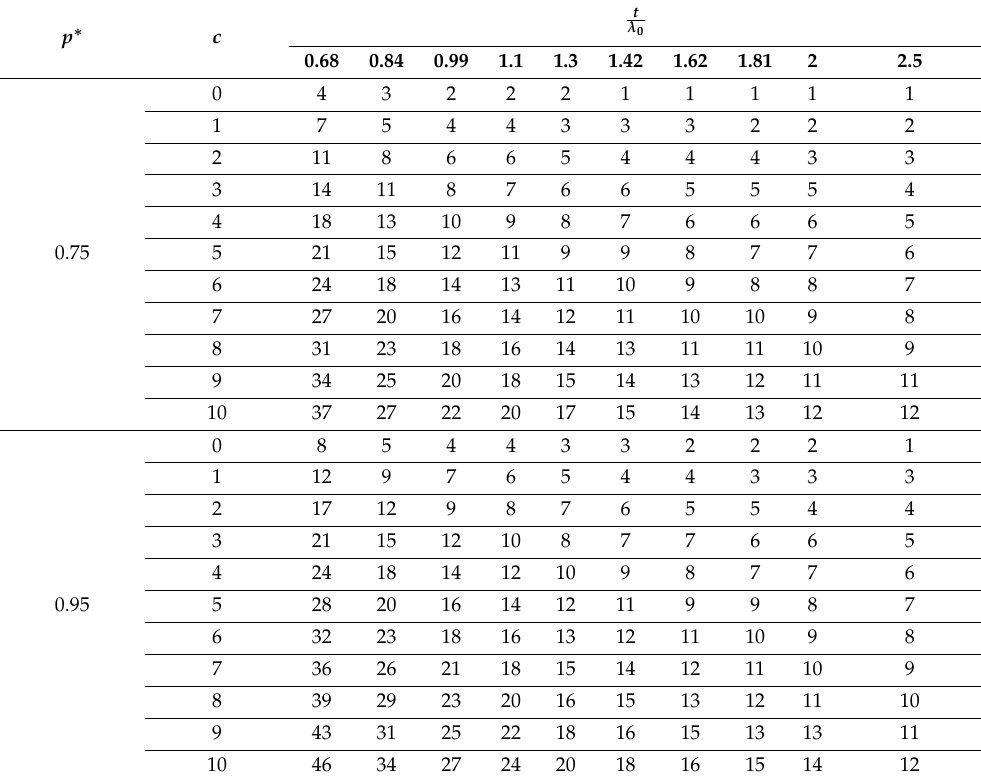
, λ = 1.3, θ = 2, and δ = 2.5 for the binomial λ 0